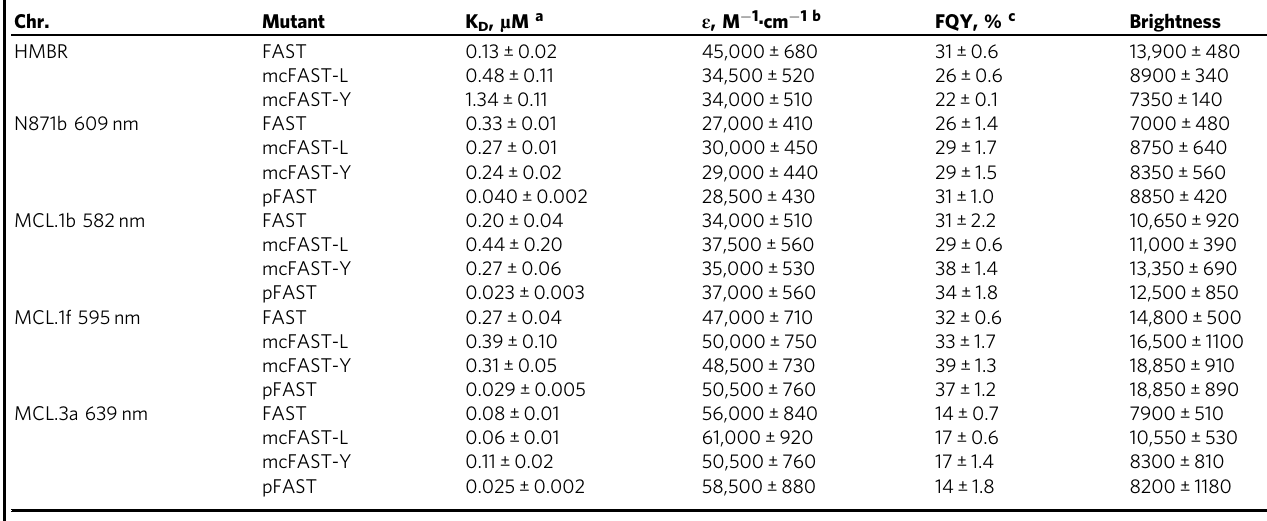
Table 1 Optical properties of HMBR, N871b, MCL.1b, MCL.1f and MCL.3a in complexes with FAST mutants.